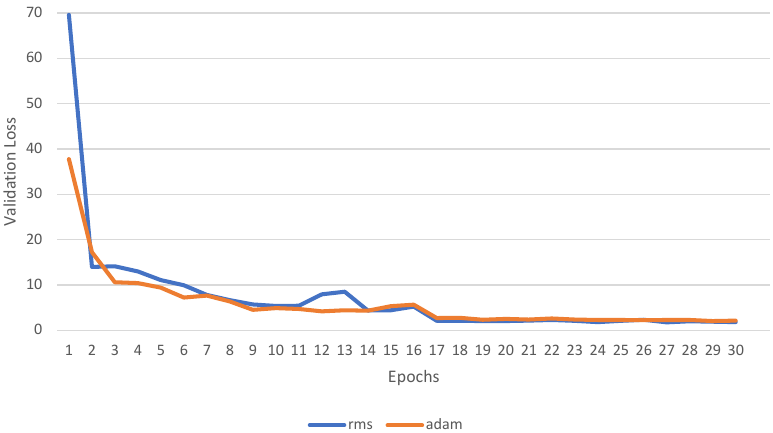
Figure 10. The proposed DCRN validation loss performance with SG layer based different